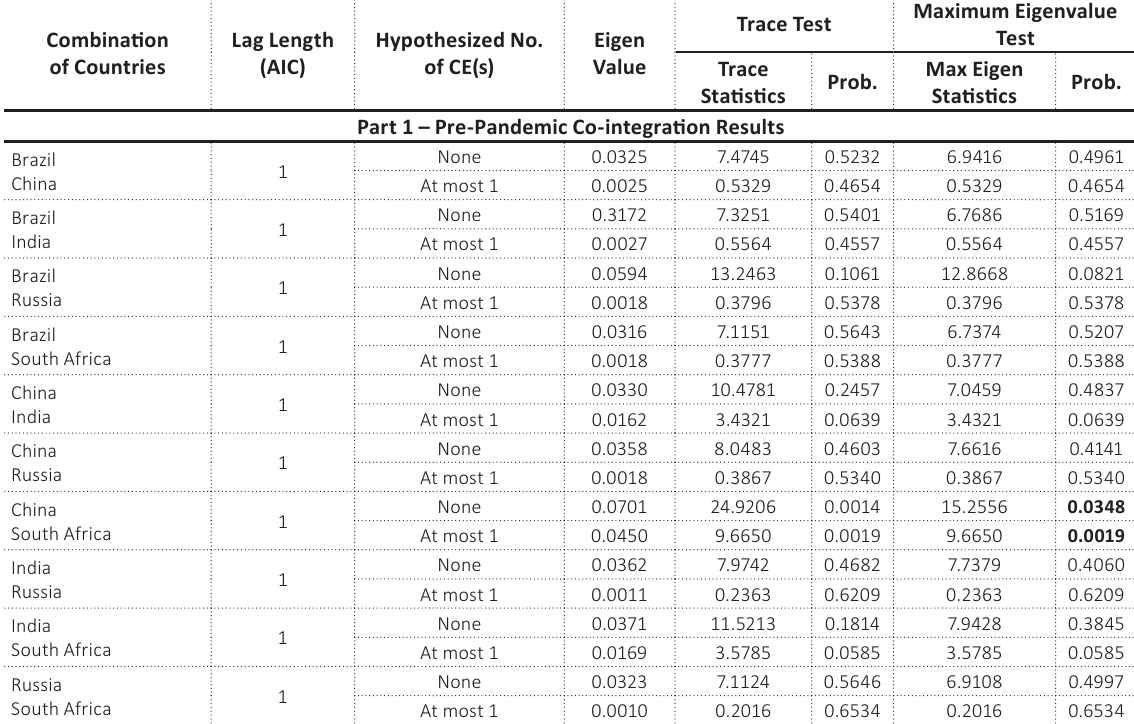
Table 4. Johansen’s co-integration